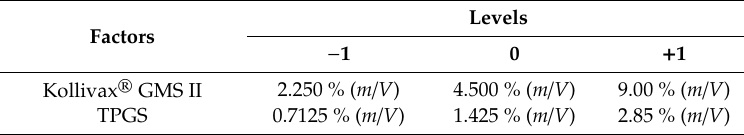
Table 3. Initial 2-level full factorial design providing the lower ( − 1), upper ( + 1) and central point (0) level values for each